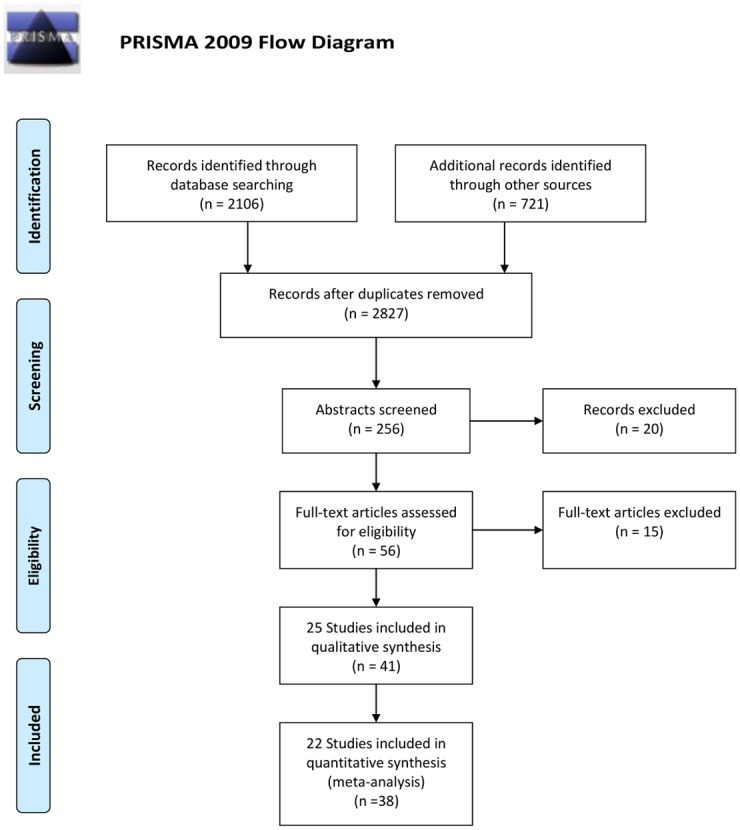
PRISMA flow diagram.
From: Moher D, Liberati A, Tetzlaff J, Altman DG, The PRISMA Group (2009). Preferred Reporting Items for Systematic Reviews and Meta-Analysis: The PRISMA Statment. PLoS Med 6(6): e1000097. doi:10.1371/journal.pmed1000097 For more information, visit www.prisma-statement.org.